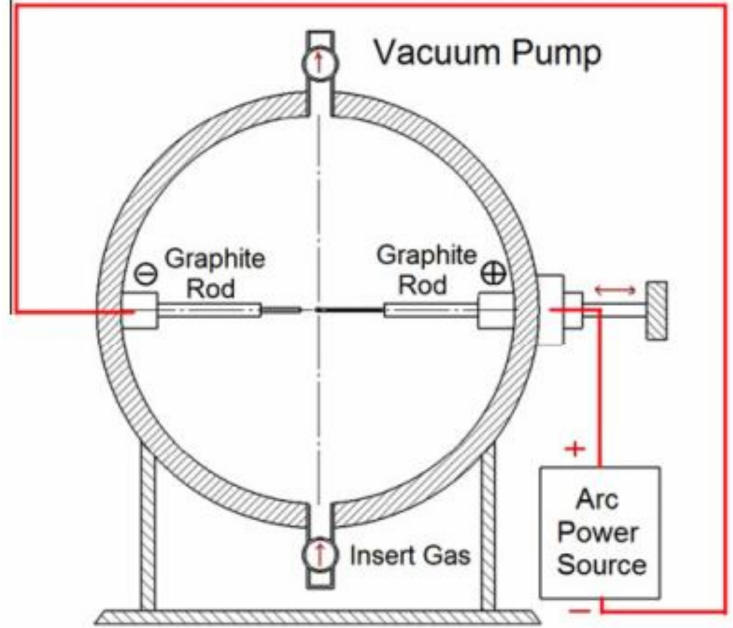
Figure 4. A schematic diagram of the DC arc discharge apparatus. (Reproduced from [70] with permission. Copyright 2012, Elsevier, Amsterdam, The